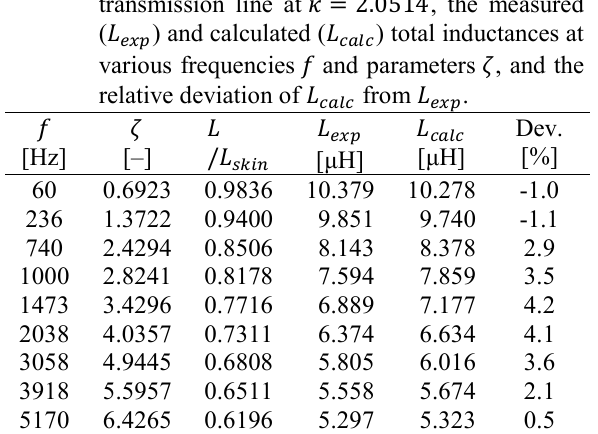
Table 1: The ratio 𝐿/𝐿 𝑠𝑘𝑖𝑛 by equation (11) of a two-wire transmission line at 𝜅 = 2.0514 , the measured ( 𝐿 𝑒𝑥𝑝 ) and calculated ( 𝐿 𝑐𝑎𝑙𝑐 ) total inductances at various frequencies 𝑓 and parameters 𝜁 , and the relative deviation of 𝐿 𝑐𝑎𝑙𝑐 from 𝐿 𝑒𝑥𝑝 .